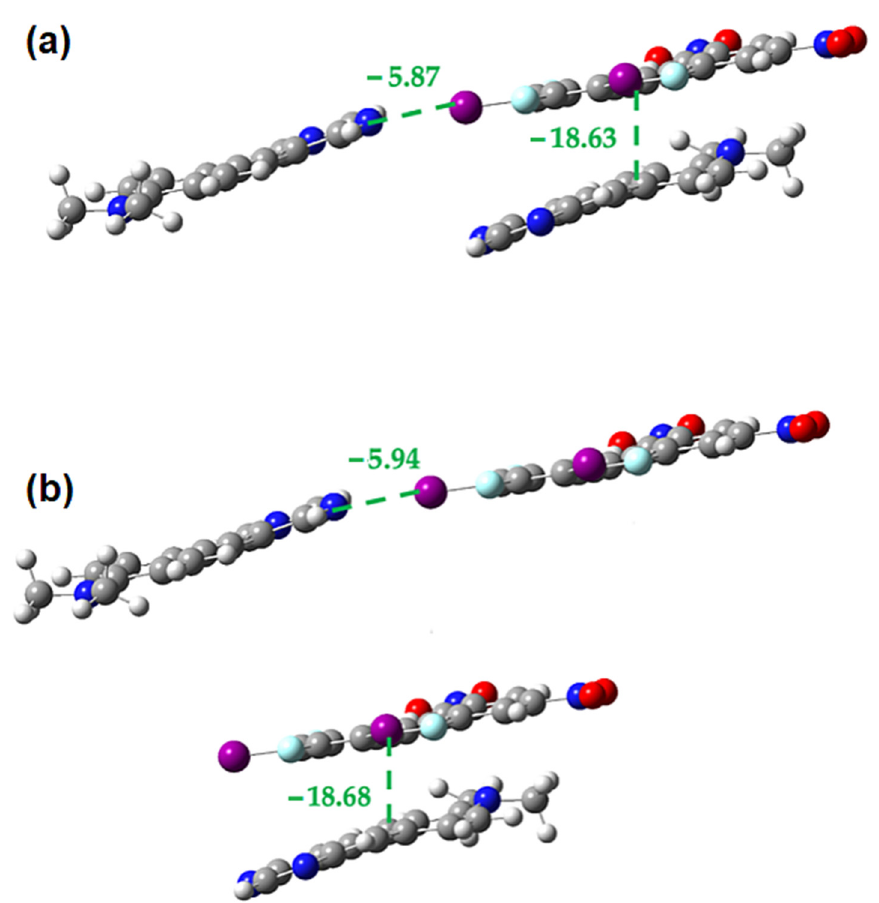
Molecules 2022 , 26 , x FOR PEER REVIEW Figure 16. M062X-D3/DGDZVP interaction energies (in kcal/mol) in the 1 • 3 cocrystal for the Figure 16. M062X-D3/DGDZVP interaction energies (in kcal/mol) in the 1•3 cocrystal for the inter- interplay between 1-3 π -stacking and halogen bonding ( a ) within trimer ( b ) in the isolated dimers. play between 1-3 π -stacking and halogen bonding (a) within trimer (b) in the isolated dimers.